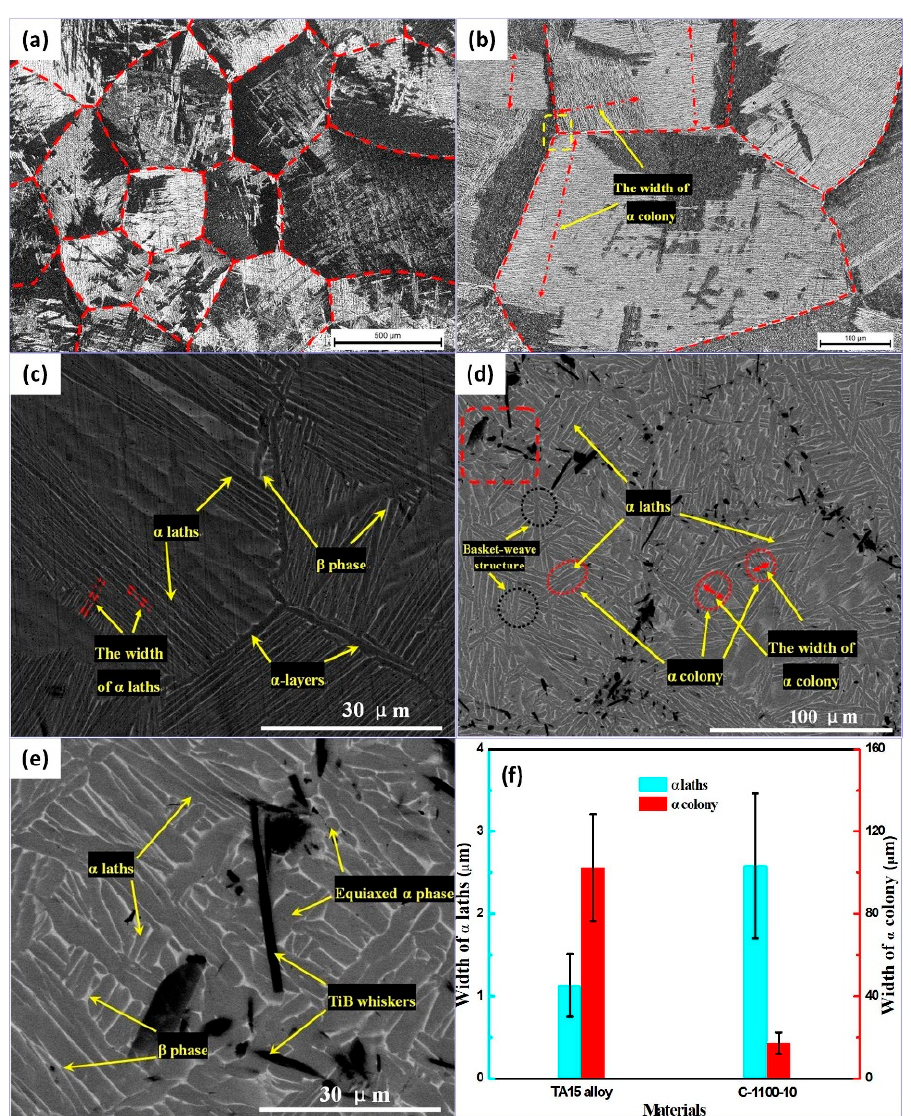
Figure 9. The optical microscope and SEM micrographs: ( a , b ) OM images of TA15 titanium alloy; ( c ) SEM image of TA15 titanium alloy; ( d , e ) SEM images of TiBw / TA15 composites. ( f ) The average width of the α colony and α laths located in the α colony.